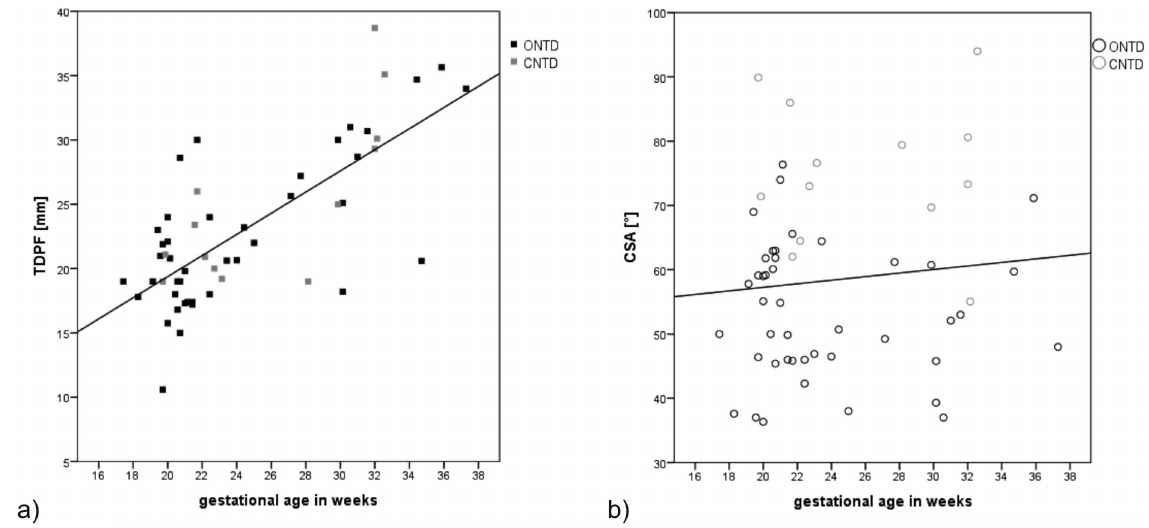
Figure 4. The TDPF and CSA in fetuses with ONTDs and CNTDs plotted against gestational age. a) Correlation of the TDPF with gestational age was significant (r=.943, p , .000) (see correlation line). b) The CSA in fetuses with ONTDs and CNTDs plotted against gestational age. Correlation was low and insignificant (r=.103, p=.452). doi:10.1371/journal.pone.0112585.g004 PLOS ONE |